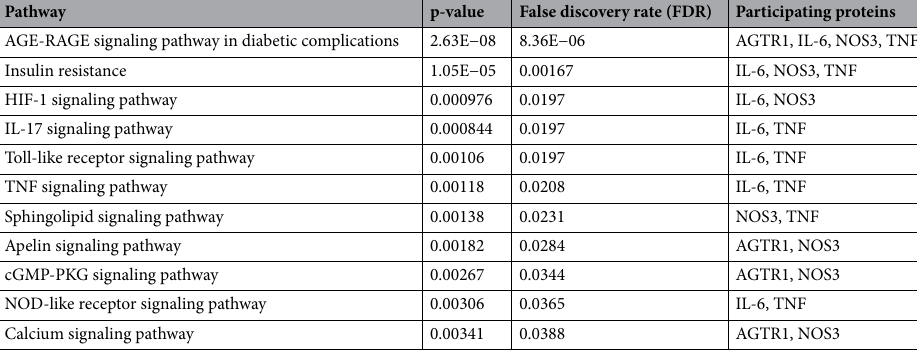
Table 2. Pathways predicted to be affected by rs5186, rs1799983, rs1800795 and rs1800629 variants.